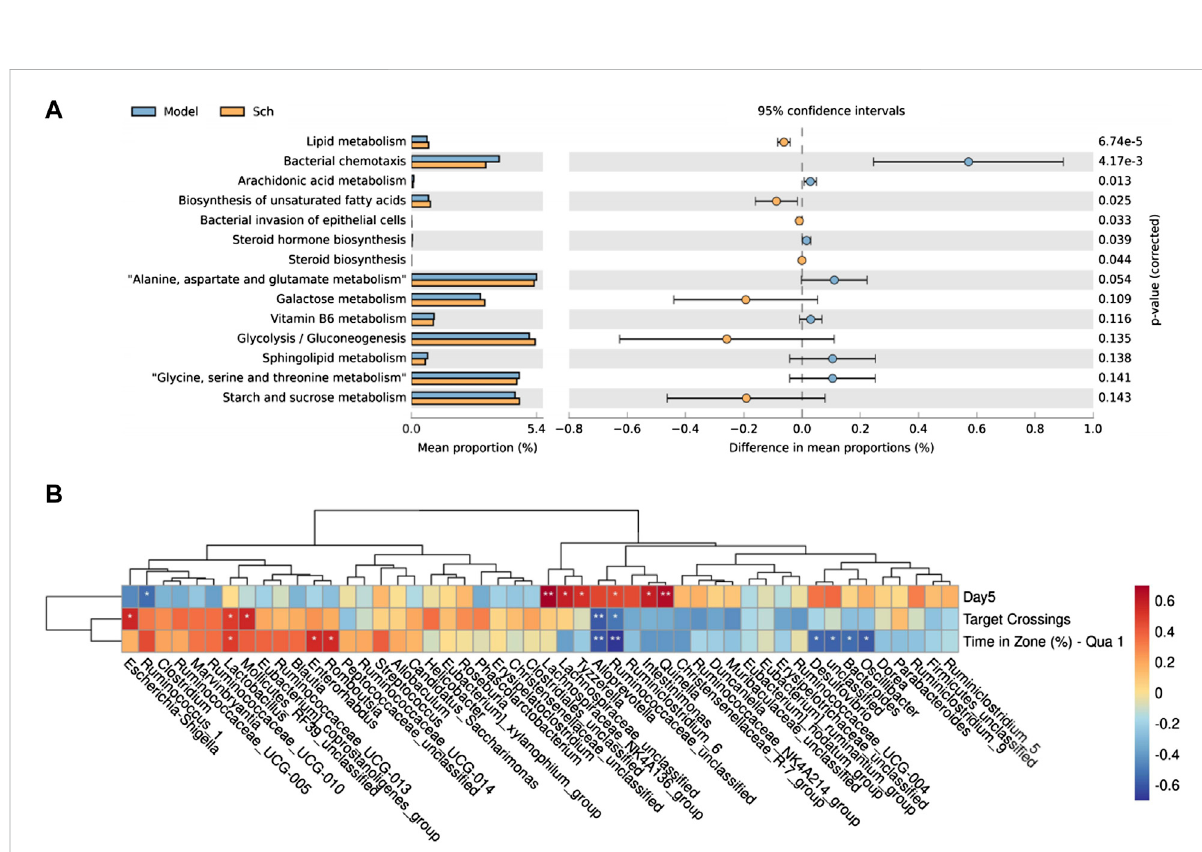
FIGURE 10 (A) PICRUSt2 analysis based KEGG database function prediction in the model group and Sch group; (B) Spearman ’ s correlation clustering heatmap between theGMandcognitiveimpairment(* p ≤ 0.05, ** p ≤ 0.01). Thecolortrendtowardredrepresents positivecorrelation,andthecolor trend toward blue represents negative correlation. Day 5 is the escape latency of the rats on the fi fth day of the space exploration experiment, target crossing is the number of times that the rats crosses the escape platform, and time in zone (%)-Qua one is time in fi rst quadrant in spatial exploration